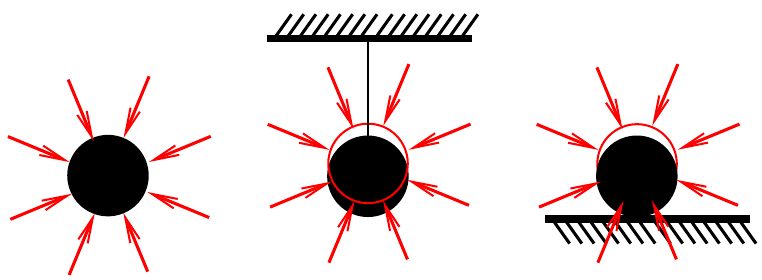
Figure 1. (from [3]) Free-falling source (left) creates standard Newton force. Static source (middle, right) creates Newton force as if the source were higher than its static geometric location, by δ G = | g | τ 2 G ∼ 10 − 3